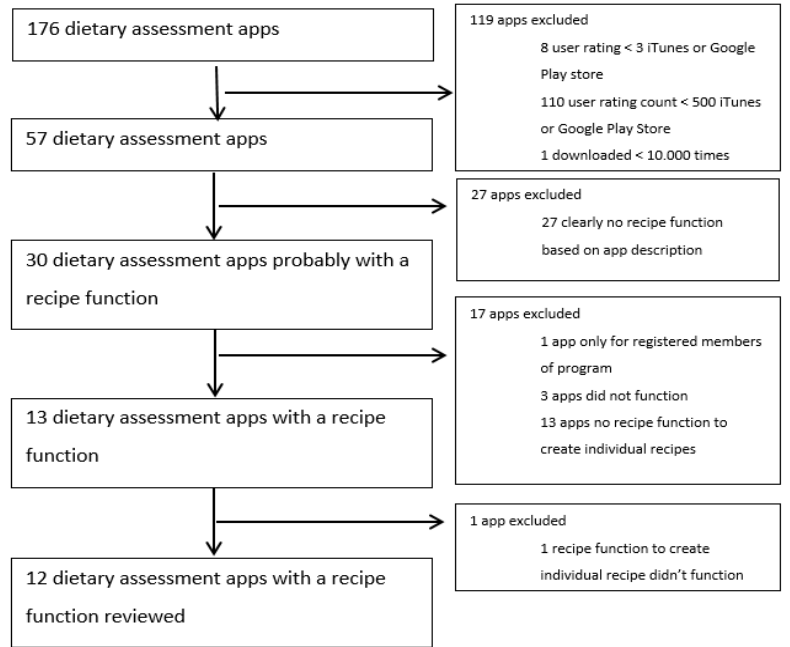
Figure 1. Flow diagram of selection procedure of dietary assessment apps with recipe function showing the number of apps included or excluded.